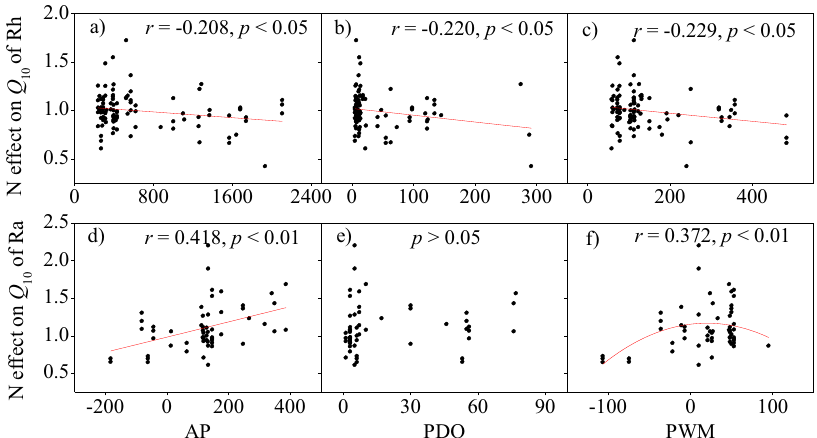
Fig. 5 Dependence of the in fl uence of nitrogen enrichment on the temperature sensitivity of soil respiration on past rainfall conditions. The relationships between indices of precipitation from paleoclimate and nitrogen effects on the temperature sensitivity of soil heterotrophic respiration ( a – c ), and autotrophic respiration ( d – f ) across all ecosystems. AP, PWM, and PDQ denote annual precipitation, precipitation of wettest month and precipitation of driest quarter, respectively. Results of linear mixed effect model are seen in Supp. Table